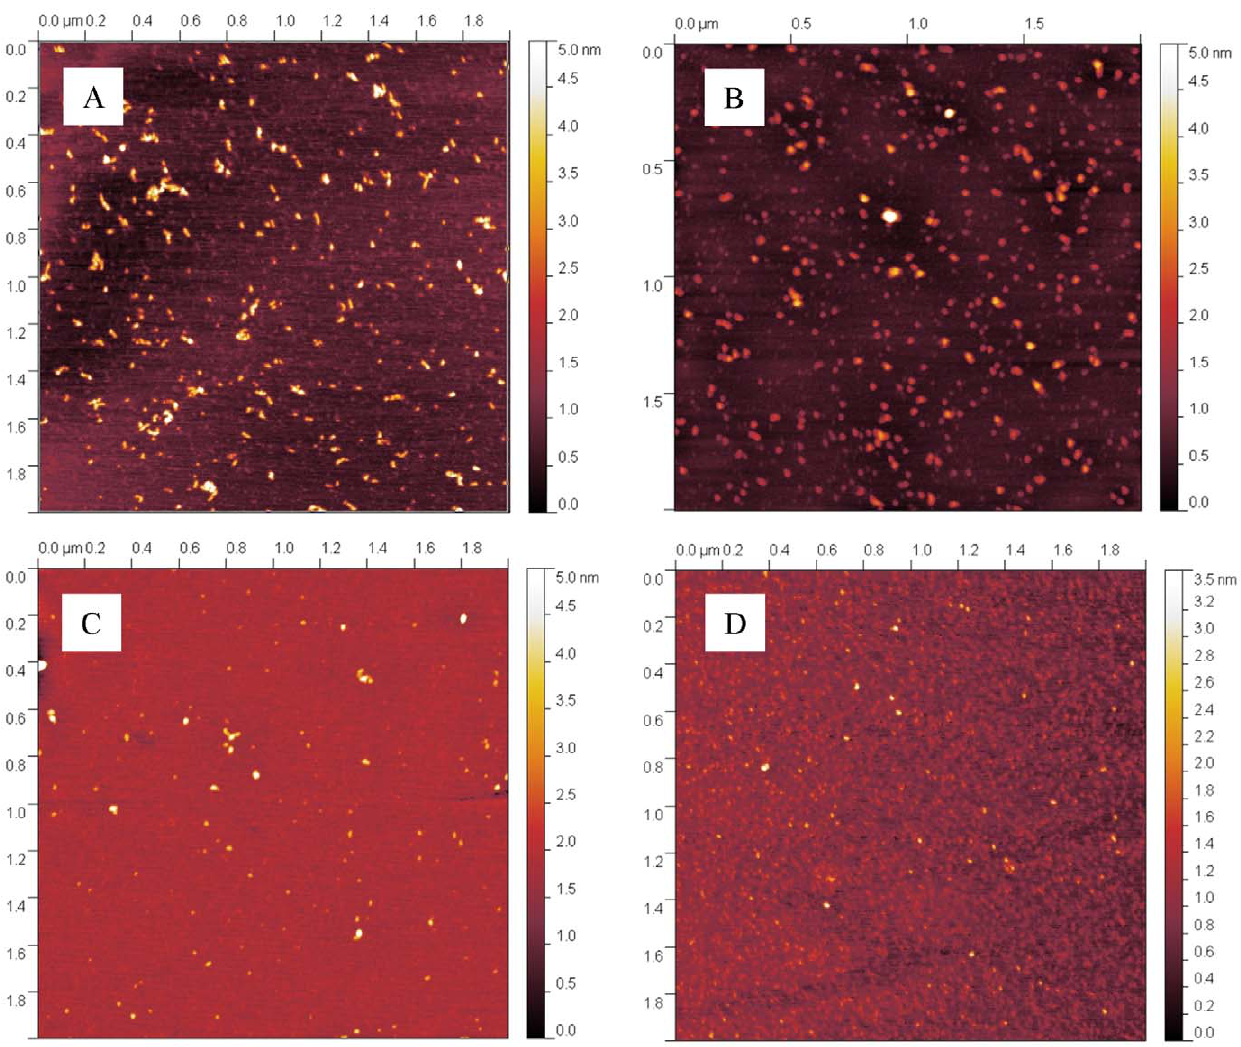
Figure 6. Aggregates morphology. AFM pictures of light chain aggregates obtained after one month incubation in 20 mM HCl at pH 2.0 with 0.45 M NaCl (A), with 0.15 M Na 2 SO 4 (B) or with 0.49 M NaH 2 PO 4 (C) and after two hours incubation in 25 mM PBS at pH 7.4, T=55 u C (D) (runs 4, 8, 6 and 11 in Table 1).